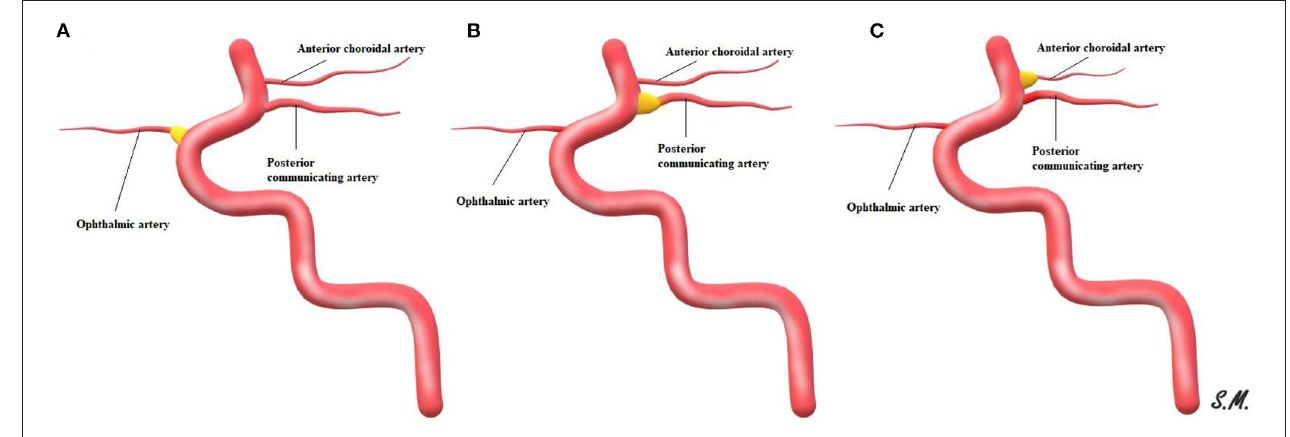
FIGURE 1 | Schematic representation of ID with the adjacent origin of an intracranial artery, ophthalmic artery ID (A) , posterior communicating artery ID (B) and ID at anterior choroidal artery (C)